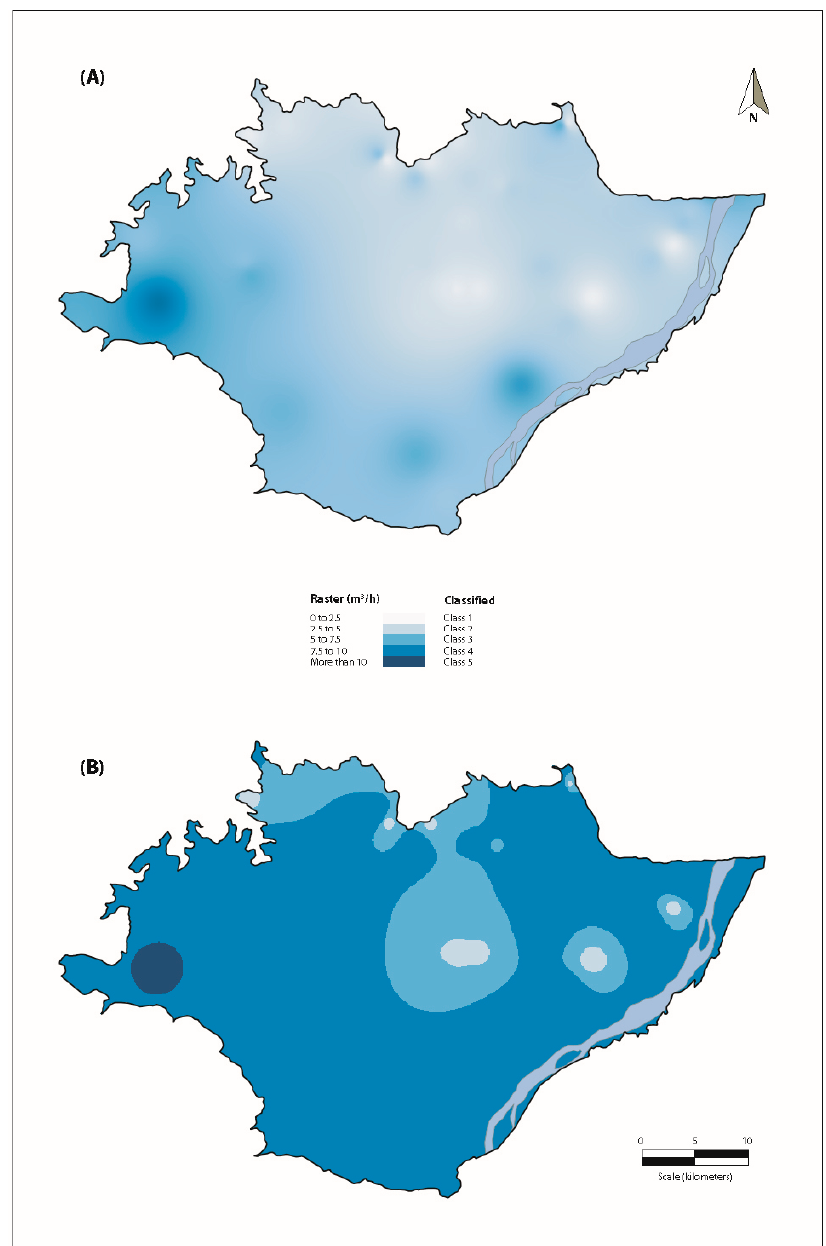
Figure 6. ( A ) Raster and ( B ) classified outcome for mechanized borehole yield. Estimates based on official data [65].